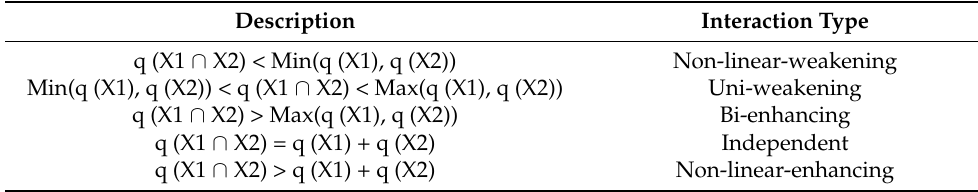
Table 2. Interaction detector model and interaction types.